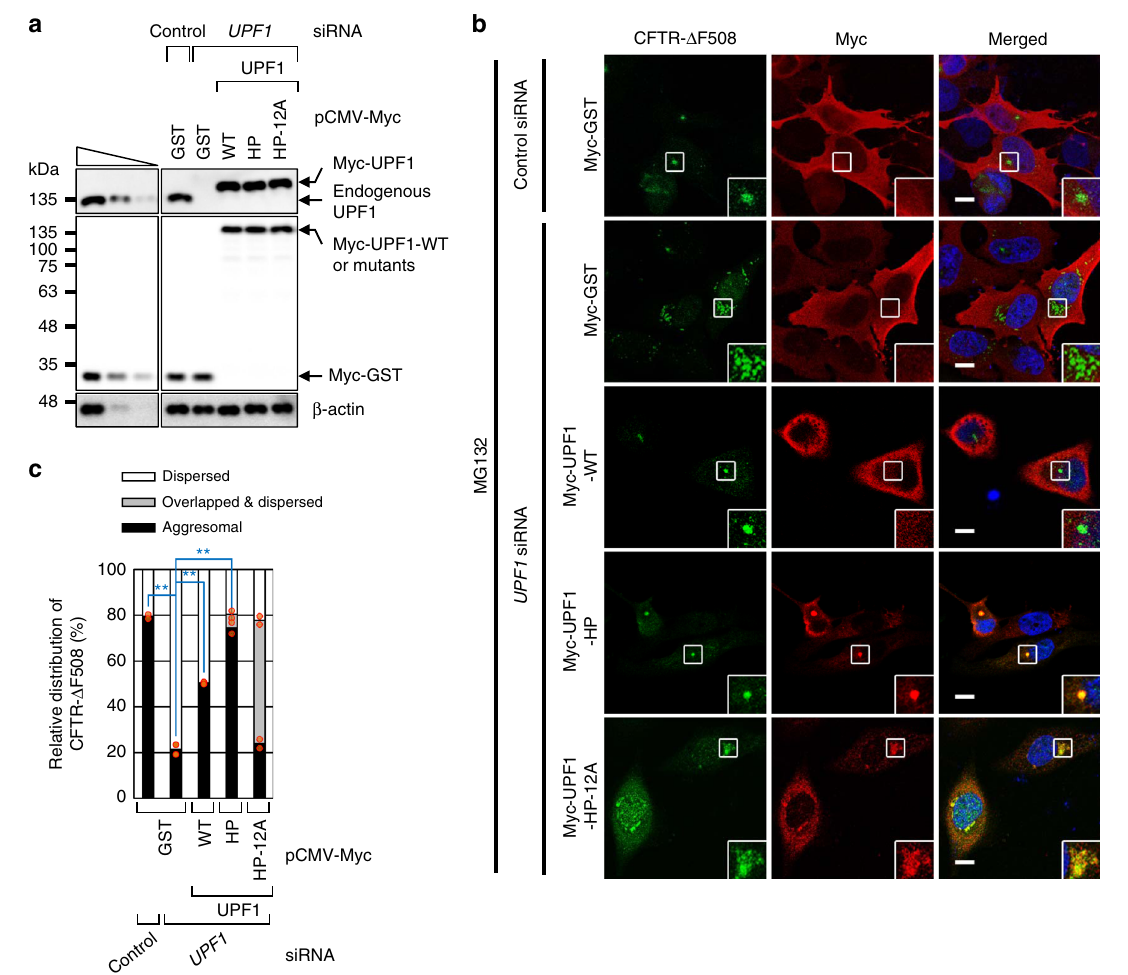
Fig. 4 Ef fi cient aggresome formation requires UPF1 hyperphosphorylation. HeLa cells stably expressing CFTR- Δ F508 were either depleted or not depleted of endogenous UPF1. One day later, the cells were retransfected with a plasmid expressing siRNA-resistant UPF1 [either wild type (WT) or one of the variants] or a plasmid expressing GST, which served as a negative control. Then, the in fl uence of UPF1 on CFTR- Δ F508 aggresome formation was analyzed by immunostaining. a Western blots showing selective downregulation of UPF1 and comparable expression levels of Myc-UPF1 and endogenous UPF1; n = 2. b Immunostaining of CFTR- Δ F508 (green) and either exogenous UPF1 or GST (red). Scale bar, 10 μ m; n = 2. c Relative percentages of the cells with different intracellular distributions of CFTR- Δ F508: aggresomal, dispersed, or dispersed but overlapping with exogenous UPF1. As performed in Fig. 2, except that immunostaining images from panel b were analyzed. To accurately assess the effect of exogenously expressed UPF1 on aggresome formation, the distributions of CFTR- Δ F508 were determined only in the cells expressing either exogenous UPF1 or GST. Two-tailed, equal-sample variance Student ’ s t test was carried out to calculate the P values. ** P < 0.0057. The exact P values are provided in a Source Data File; More than 100 cells were analyzed from two independent experiments; Source data are provided as a Source Data